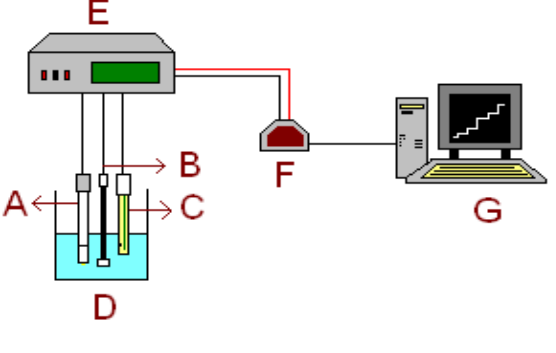
Figure 2. Measurement system used. A: Sulpiride selective electrode; B: Stirrer; C: Reference electrode; D: Sample; E: Potentiometer; F: Analogue-to-digital converter; G: Personal